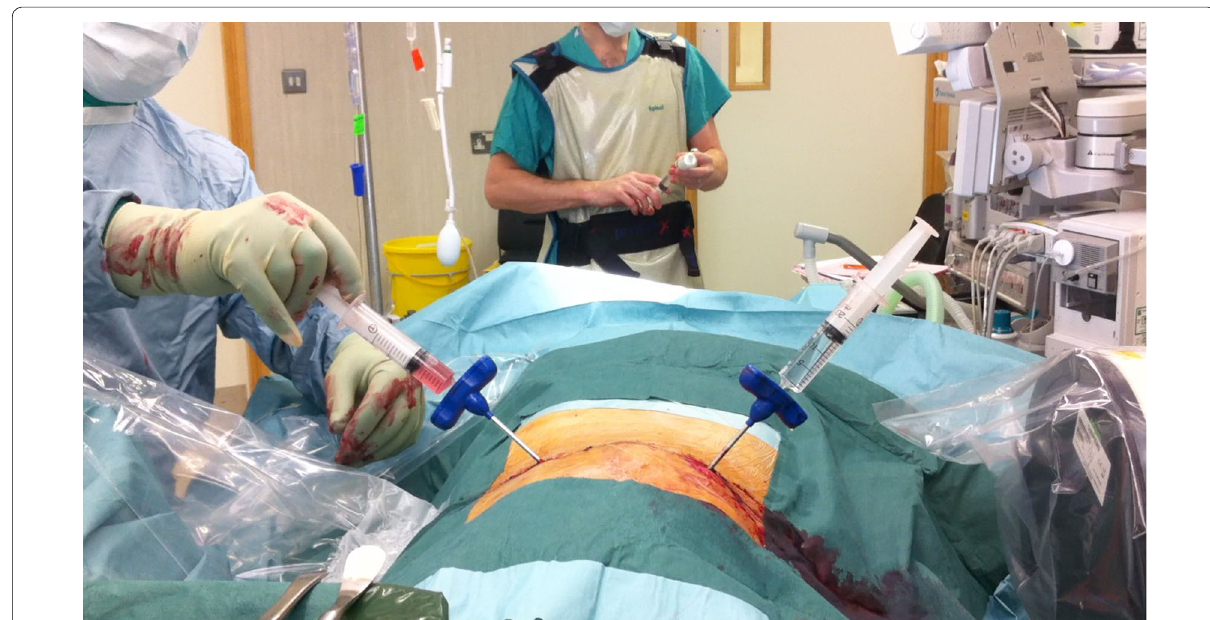
Fig. 1 Intraoperative positioning of the patient. The patient is positioned prone on bolsters. The surgical area is draped and a C‑arm is positioned perpendicular to the patient for intraoperative monitoring of needle placement